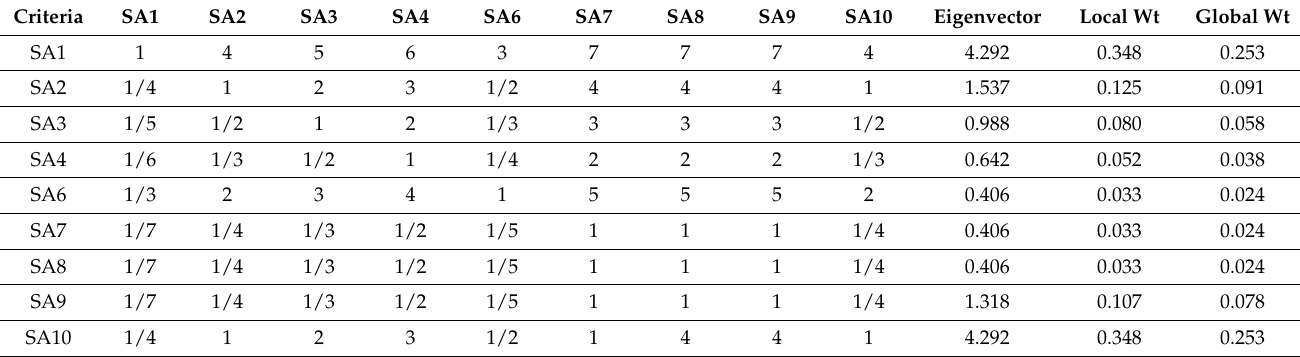
Table A2. Safety subcriteria comparison matrix.